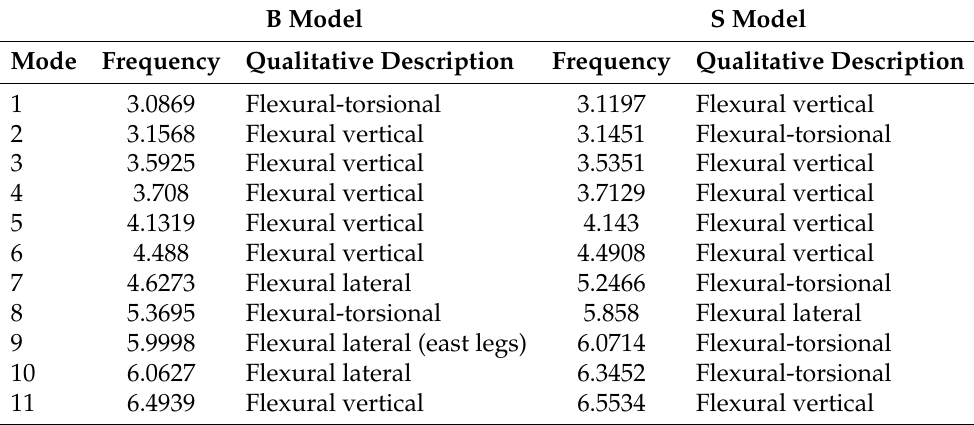
Table 7. Summary of first 11 natural frequencies from B and S models